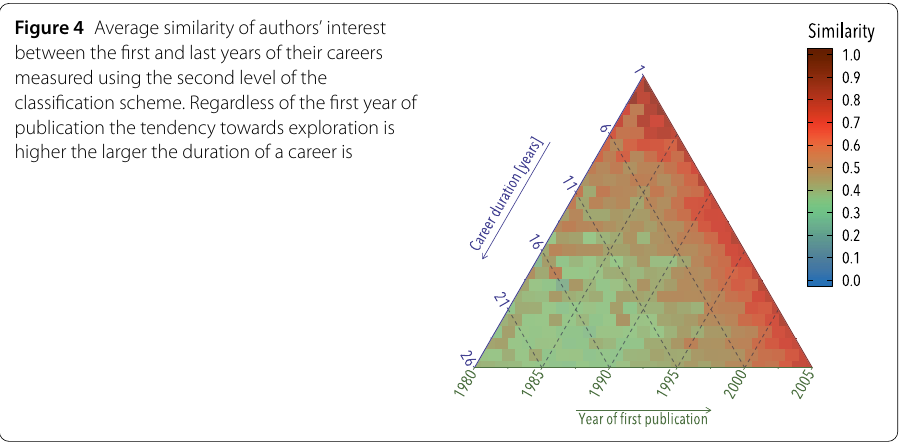
Figure 4 Average similarity of authors’ interest between the first and last years of their careers measured using the second level of the classification scheme. Regardless of the first year of publication the tendency towards exploration is higher the larger the duration of a career